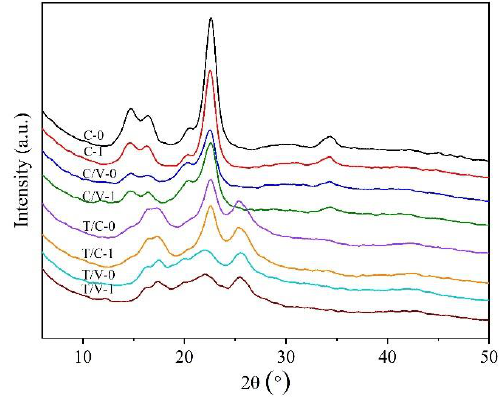
Figure 12. XRD spectra of original and dipping process-treated fabrics.